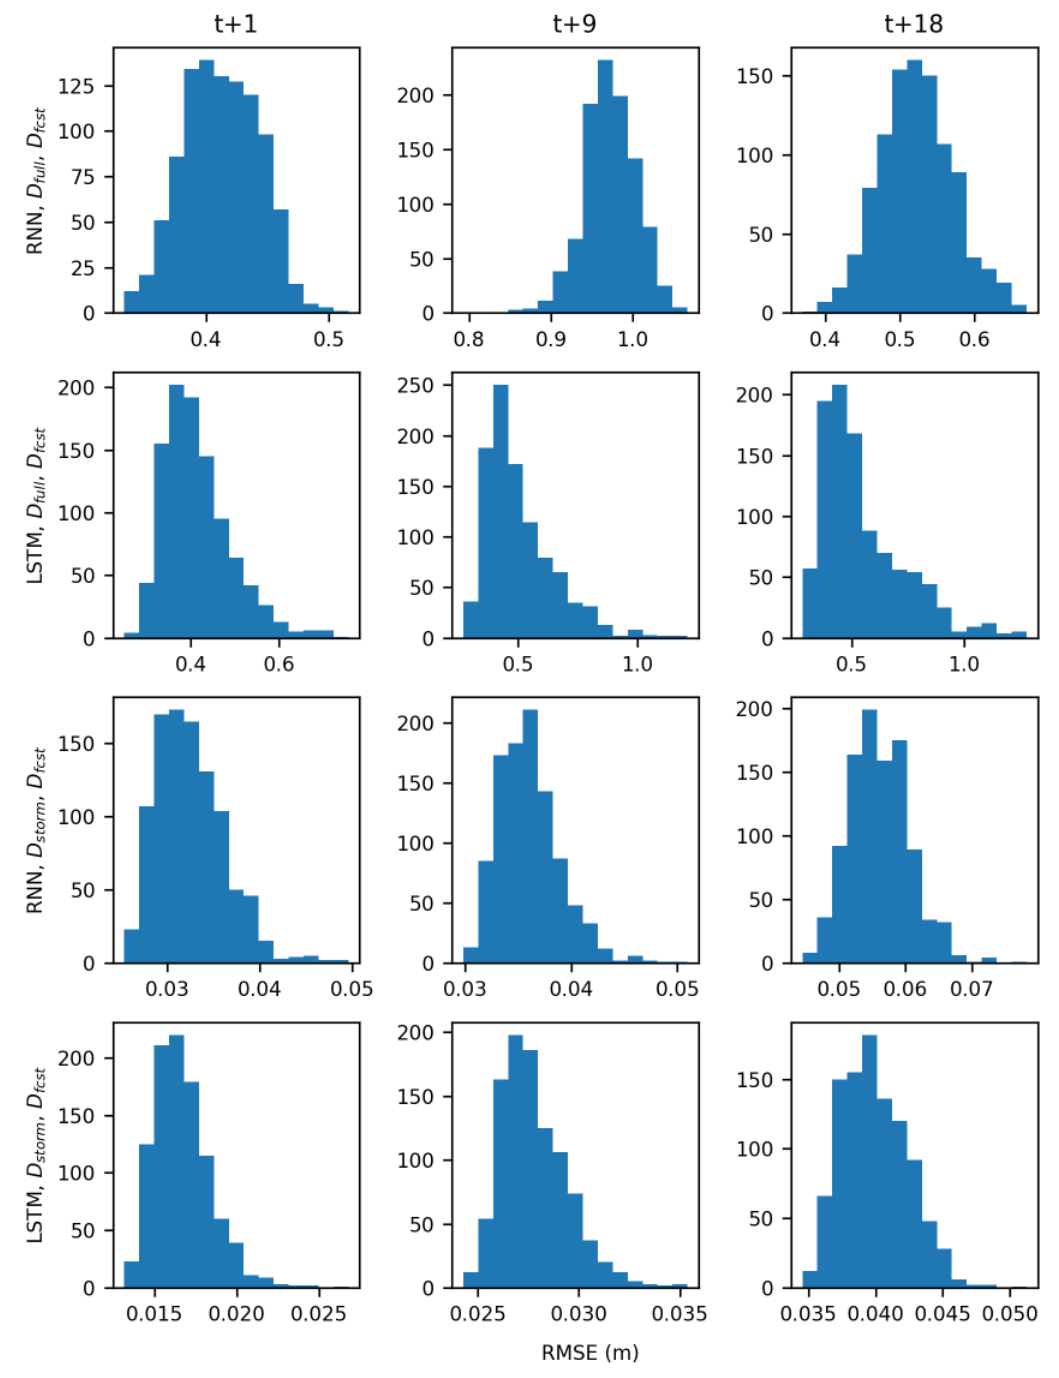
Figure A13. RMSE distributions for GW6 using forecast input data. Columns represent the forecast horizons t + 1, t + 9, and t + 18. Rows are specified as model type, training data, and testing data.